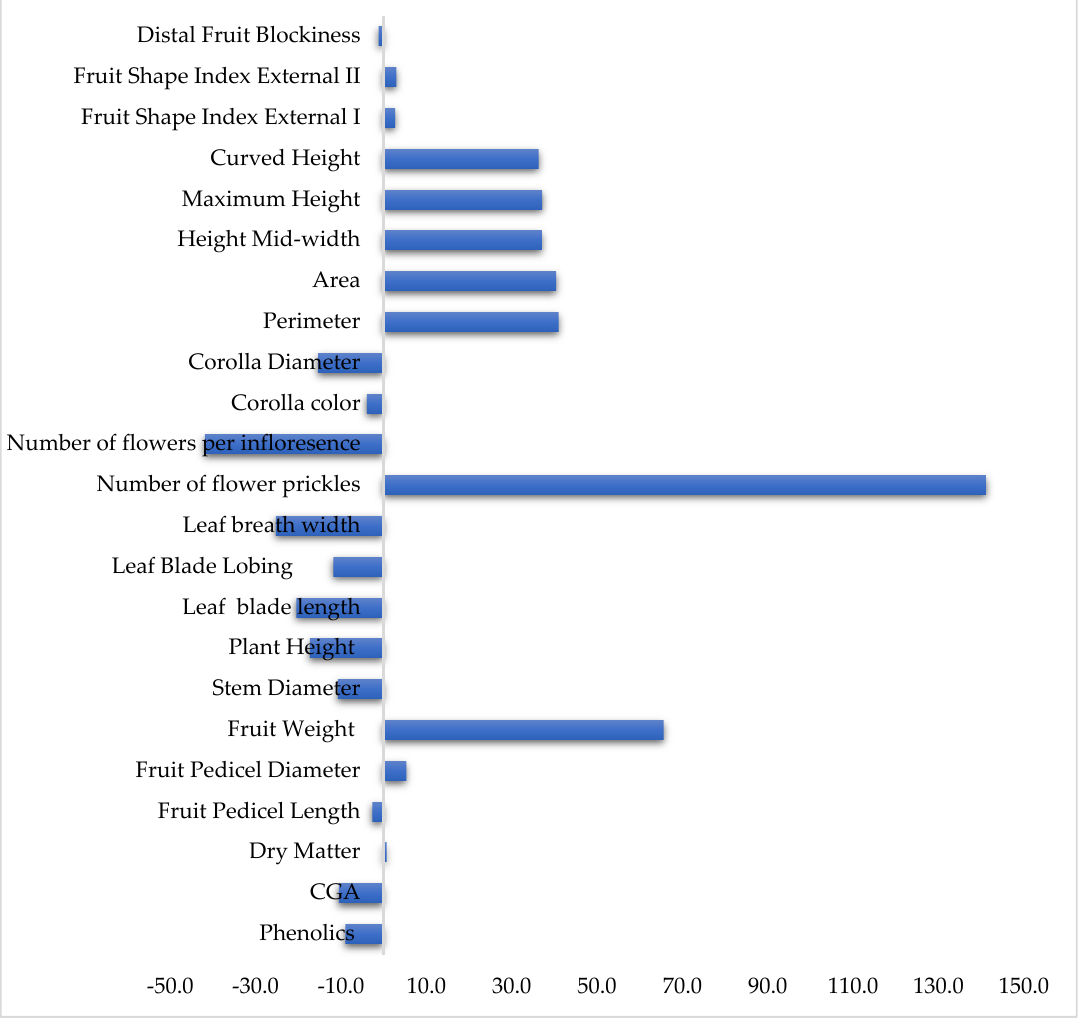
Figure 2. Heterosis over mid-parent values for all the descriptors studies.